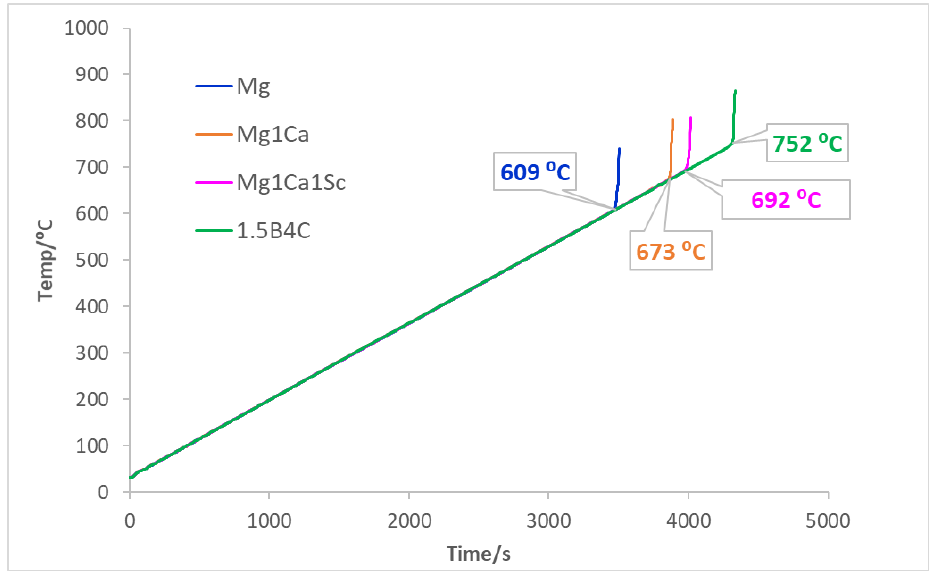
Figure 5. Ignition temperatures of Mg, the Mg alloys and the Mg